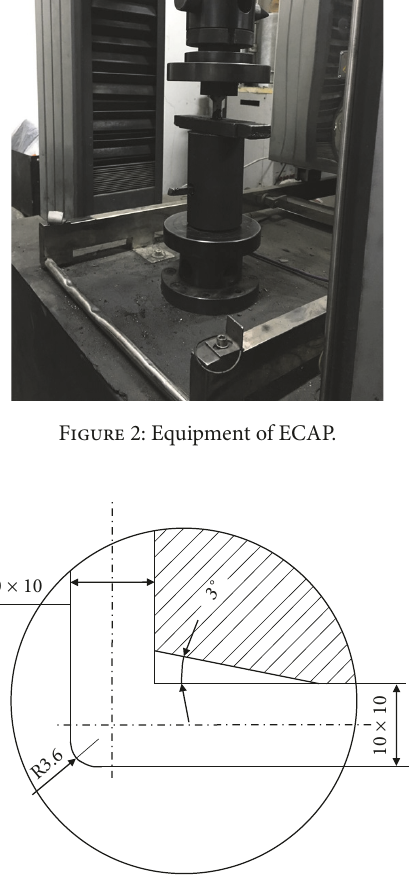
Figure 3: Internal structure of bottom die.